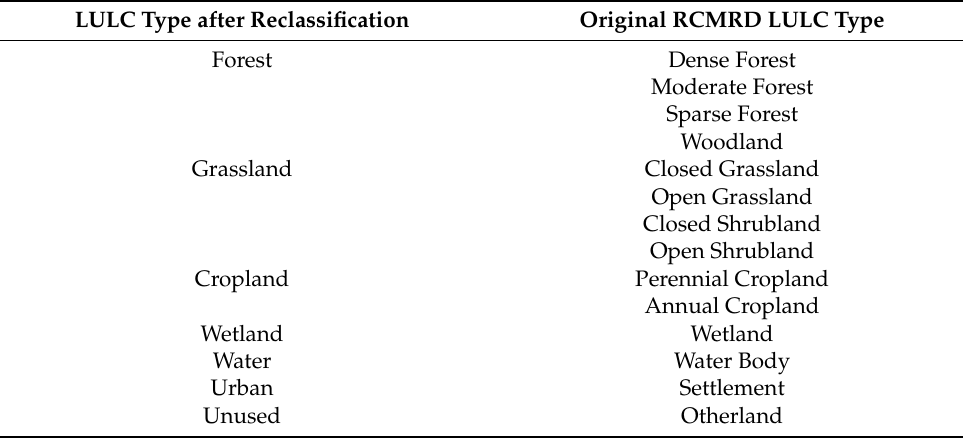
Moderate Forest Sparse Forest Woodland Open Grassland Closed Shrubland Open Shrubland Annual Cropland